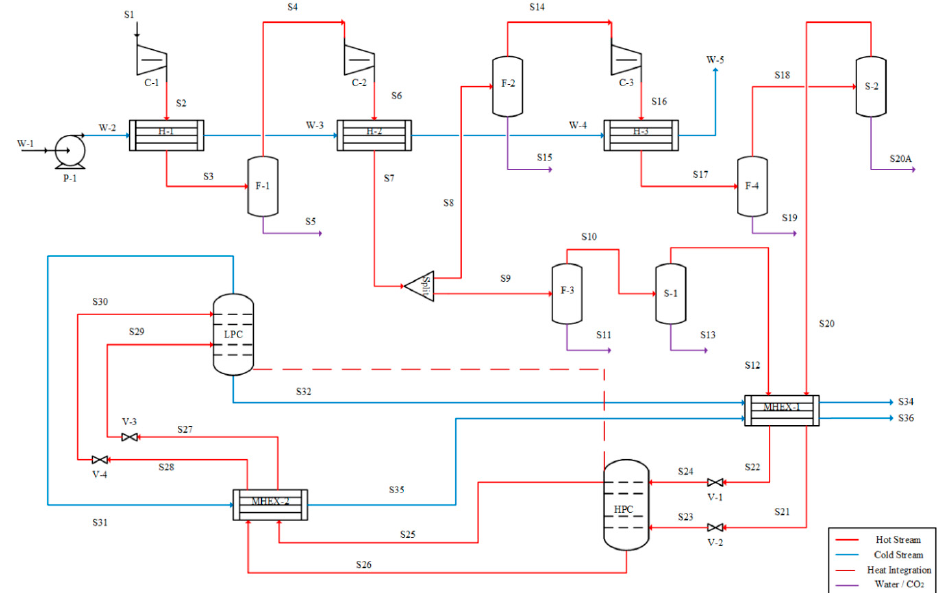
Figure 2. Process flow diagram of the ASU configuration C2.